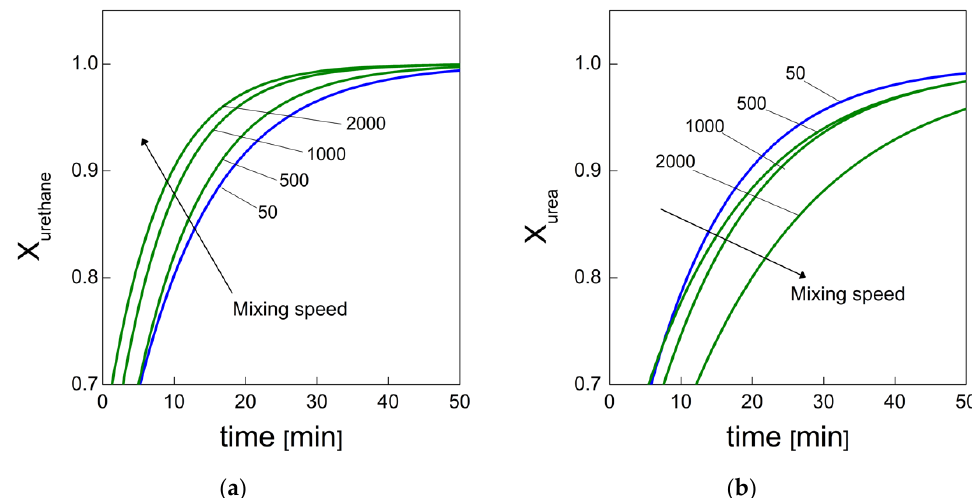
Figure 12. ( a ) Degree of urethane formation and ( b ) degree of urea formation reacted at different mixing speeds as a function of reaction time.